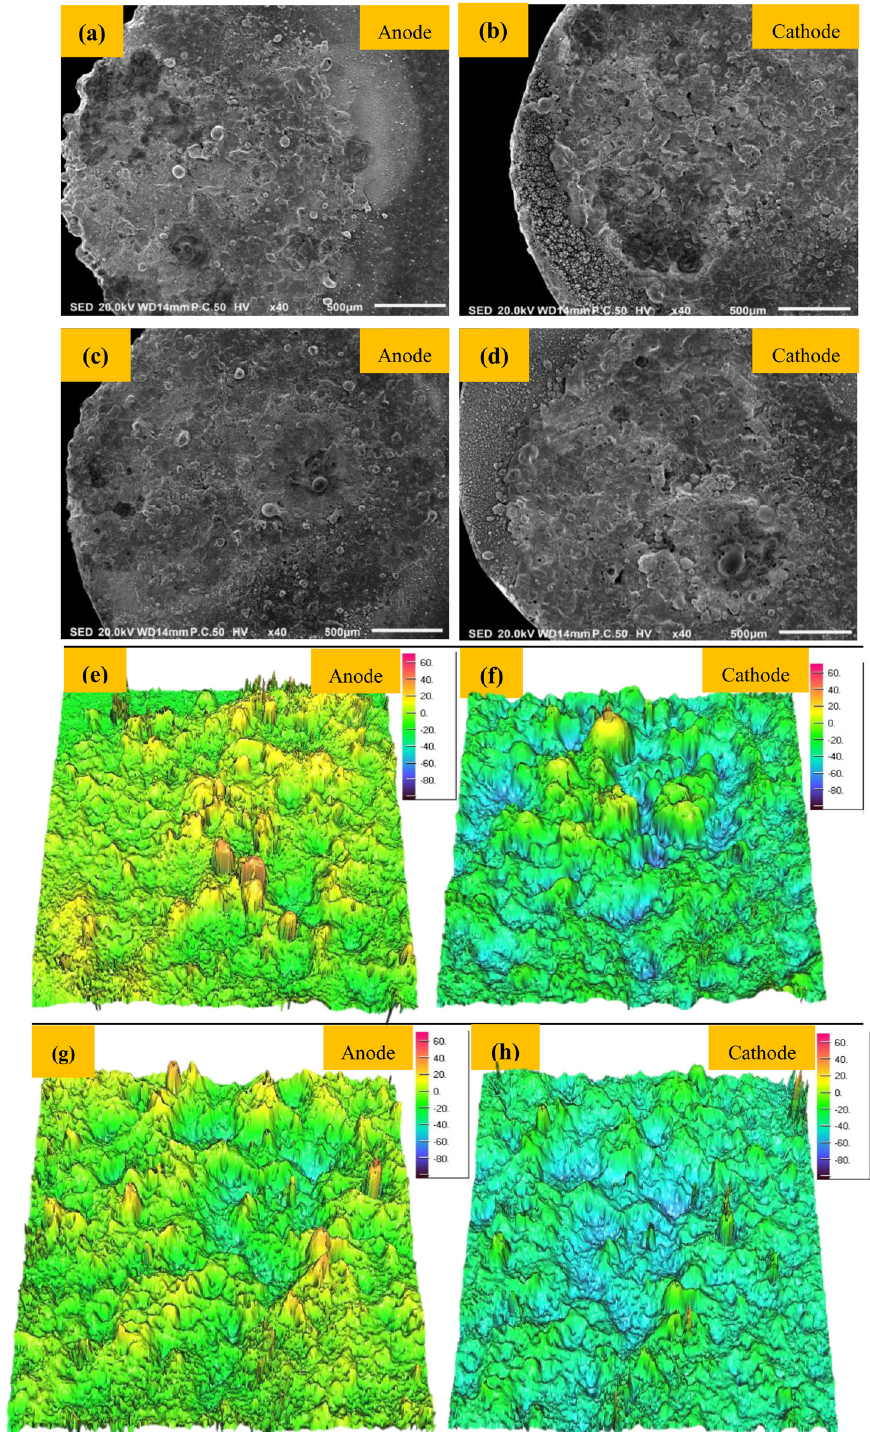
Figure 7: SEM images of arc erosion morphology and corresponding 3D pro fi les ( a, b, e, and f ) 0.5GO/0.5CeO 2 – Cu30Cr10W; ( c, d, g, and h ) 1.0GO/0.5CeO 2 –